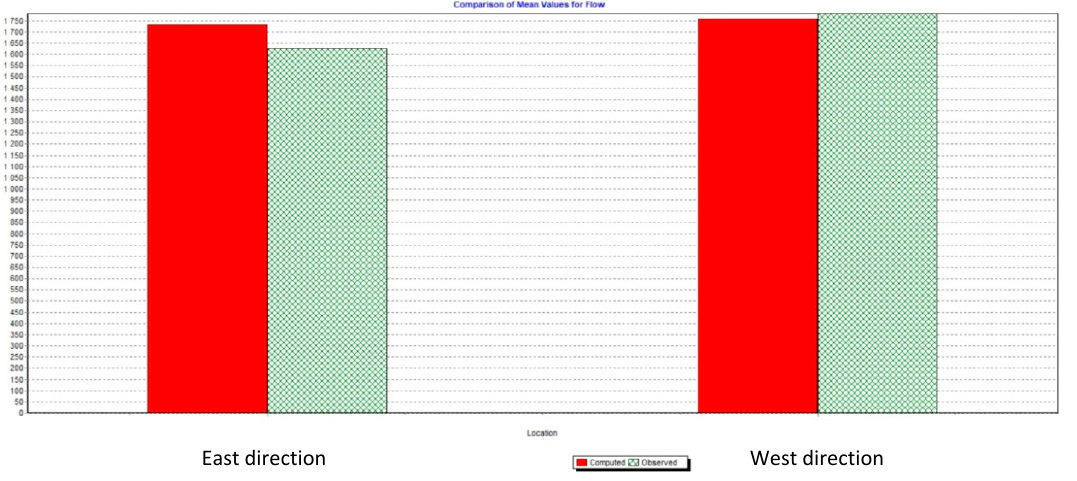
Figure 13. Simulation results for Scenario